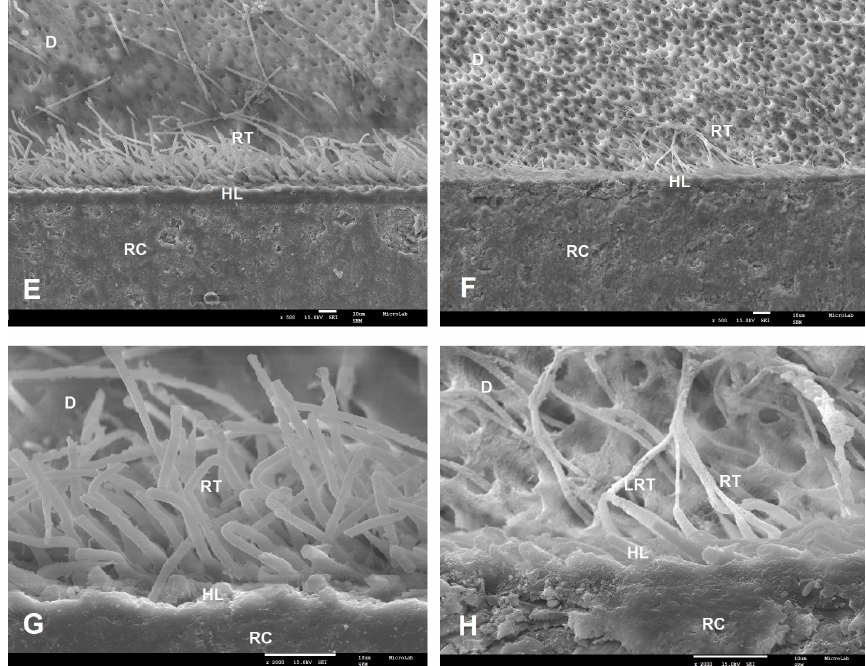
Figure 2. SEM micrographs of the bonding interface of the experimental adhesives when ER was applied. Magnifications of 500 × ( E , F ) and 2000 × ( G , H ) were used. E and G —AE1 with 12.3 µ m of HL thickness; F and H —AE2 with 11.2 µ m of HL thickness and resin tags (RT) with 18.2 µ m in length. RC—resin composite; D—dentin; HL—hybrid layer; RT—resin tags; LRT—lateral resin